Question: Summarize what this figure shows in one sentence.
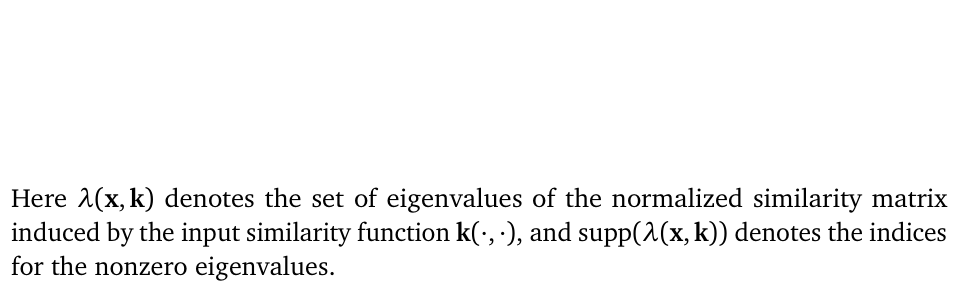
Answer: Sensitivity of Different Vendi Scores Under Different Scenarios. (A) Varying the number of classes under perfect balance. Each Vendi score measures the number of classes exactly; they are effective numbers. (B) Varying the number of classes under imbalance. Smaller orders q more accurately describe the correct number of modes. (C) Combining two similarity functions for shape and color. All choices of order q except q = ∞give increases in diversity with the similarity composition. (D) Varying the correlation of shape and color features. As the correlation between shape and color decreases from left to right, all q except q = ∞ yield larger Vendi scores. (E) Decreasing the similarity between class members. q = ∞gives a Vendi Score that is more resistant to intra-class variance. For smaller qs, the Vendi scores increase with larger amounts of variance, although the Vendi score with q = 0.1 decreases slightly between example S2 and S3.